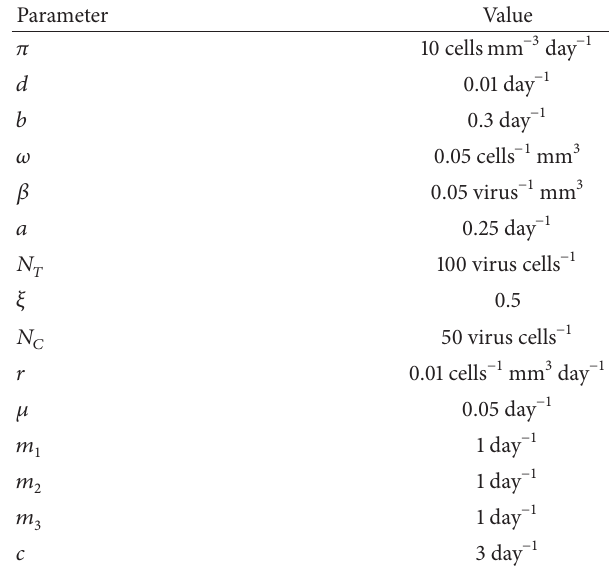
Table 1: The parameters of model